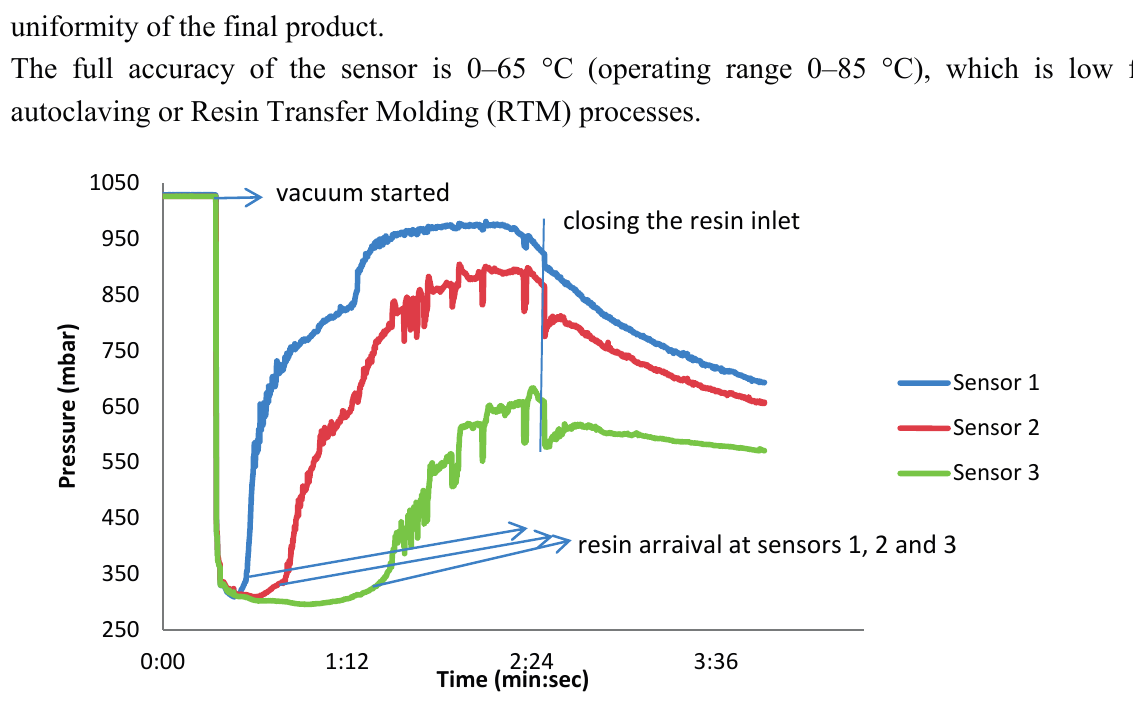
Figure 2. Real-time pressure profile inside the fiber composite laminate, measured by BOSCH pressure